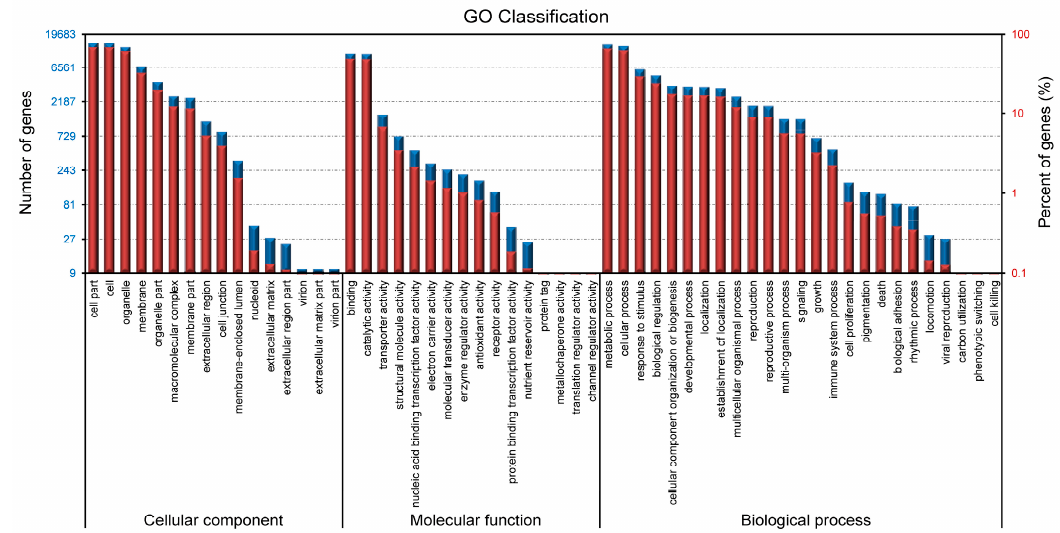
Figure 3. Summary of GO function annotation of assembled tepal transcriptome of Chinese narcissus. The composition of the second level GO terms is divided into three major categories: biological process, cellular components, and molecular function. The terms in each category are sorted based on the number of unigenes in each term. Percentages of unigenes in each term of the three categories are shown.